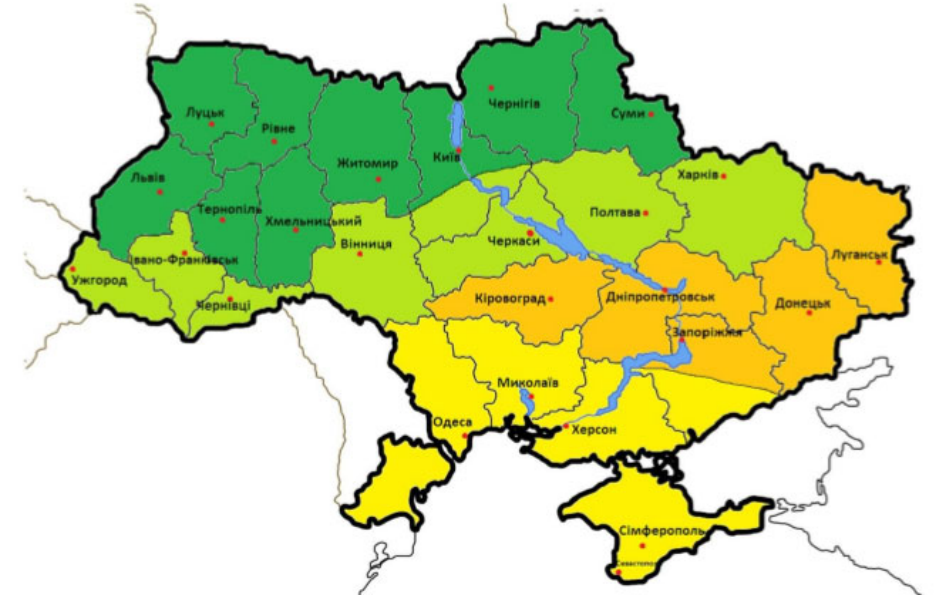
Fig. 1. Pond aquaculture zones of